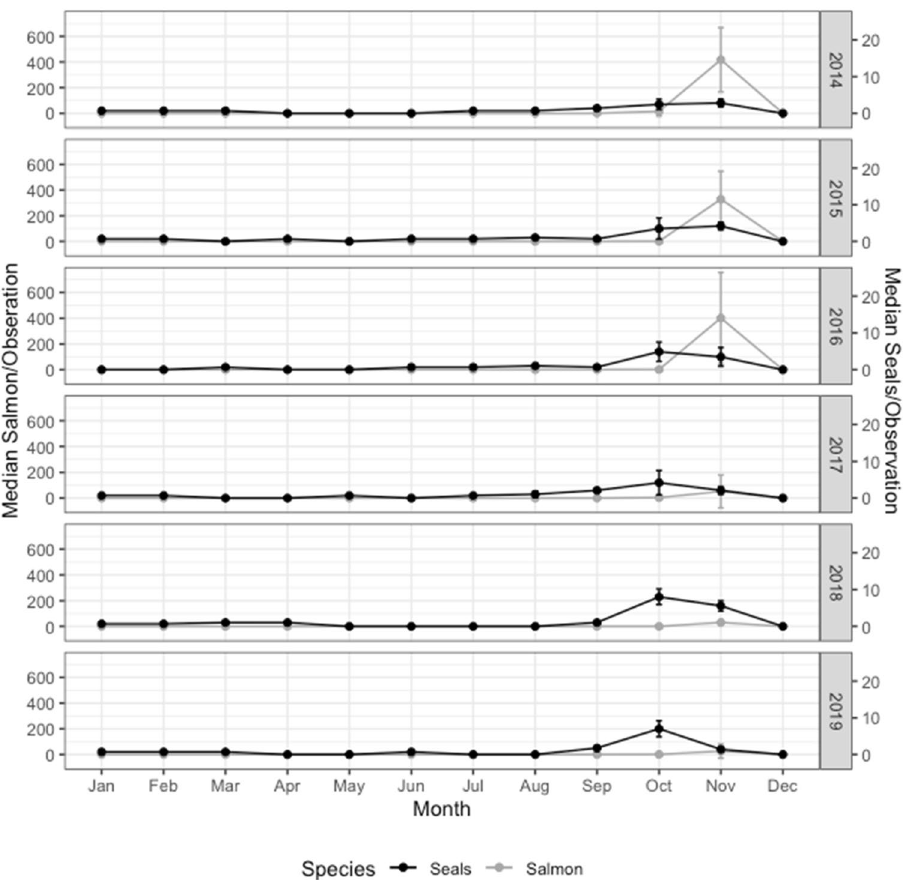
Figure 1. Median number of harbor seals present at each observation (right y-axis) and median number of salmonids present per observation relative to month and year (left y-axis). Salmonid medians were calculated as the median of a three-day rolling average corresponding to the day of observation. Error bars represent interquartile range to show spread of the data.